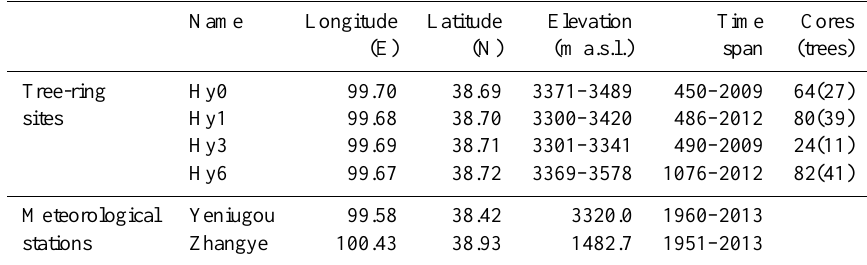
Table 1. Tree-ring sampling sites and meteorological